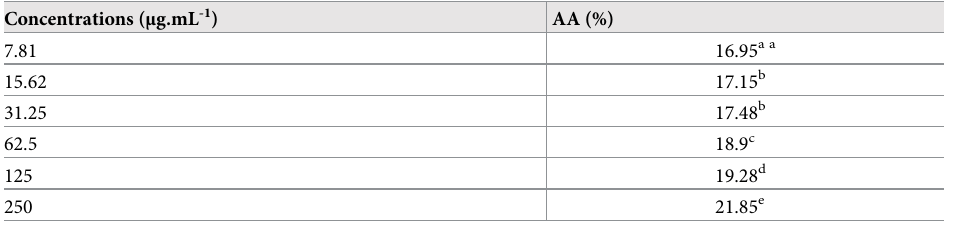
Table 4. Shows the percentage of the antioxidant activity of O . majorana L. EO.